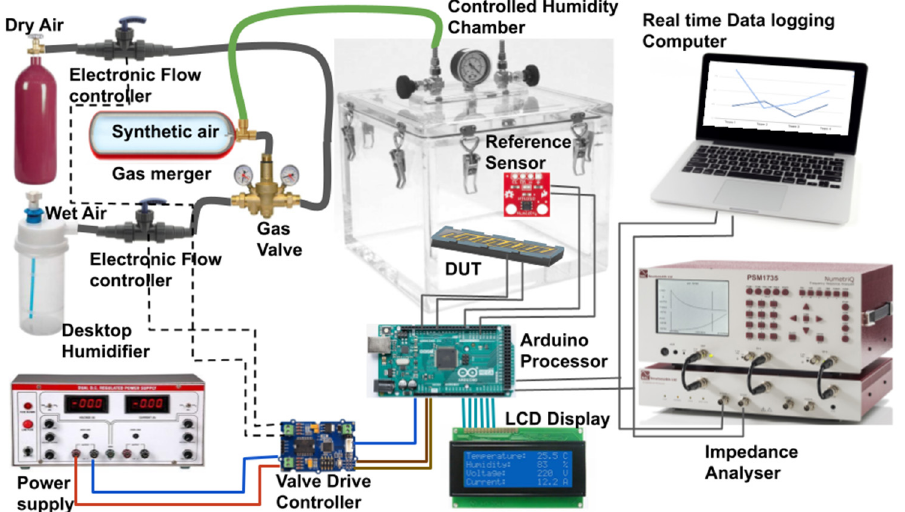
Figure 2. Humidity sensing setup.